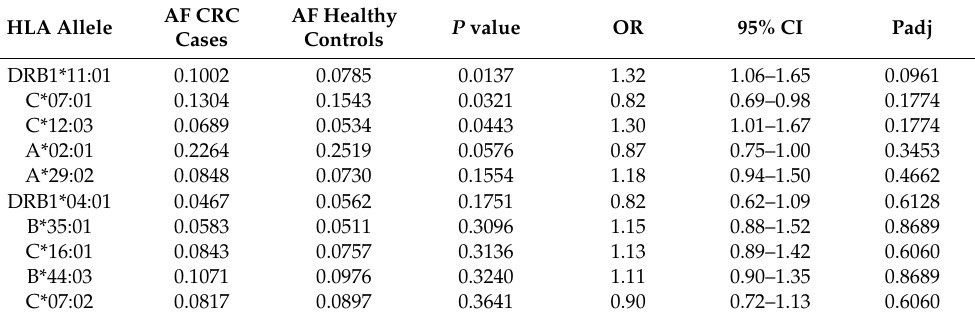
Table 3. Frequency distribution of HLA alleles between CRC cases and controls.